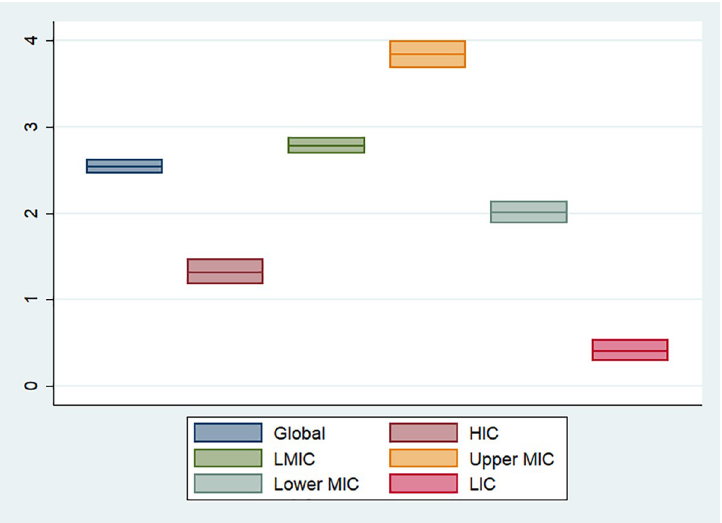
Fig 3. Pediatric COVID-19 deaths (/1,000,000 children) by country income. The ranges are presented by 95% confidence intervals of each proportion. Global includes all countries defined by World income. Abbreviations: HICs, high-income countries; LMICs, low- and middle-income countries; MICs, middle-income countries; LICs, low- income countries. https://doi.org/10.1371/journal.pone.0246326.g003 Fig). The pediatric CFRs are significantly higher in LMIC than HIC (CFR 0.29% [0.28–0.31%] in LMIC vs 0.03% [0.03–0.03%] in HIC; p < 0.001). ICU admission rates were 0.128% [0.122– 0.133%] in HIC and 0.397% [0.367–0.430%] in upper MIC; p < 0.001). Age-specific deaths and ICU admissions/1,000,000 children were 10.03 [9.07–11.07] and 16.84 [15.15–18.67] in < 1 year old, 1.64 [1.44–1.86] and 1.40 [1.16–1.67] in 1–4 years old, 0.92 [0.79–1.06] and 0.73 [0.58–0.90] in 5–9 years old, 1.13 [0.99–1.30] and 0.97 [0.79–1.12] in 10–14 years old and 2.70 [2.47–2.95] and 2.78 [2.47–3.12] in 15–19 years old, respectively (Fig 4 and S4 Table). Disaggregated age data were available in 558,961 and 242,827 children with confirmed SARS-CoV-2 infection as denominators for calculation of age-specific CFR and ICU admission rate, respectively. Age-specific CFR and ICU admission rate are shown in S3 Fig and S4 Table. Infants < 1 year old had the highest CFR (0.58% [0.50–0.67%]) and ICU admission rate (1.41% [1.27–1.56%]).